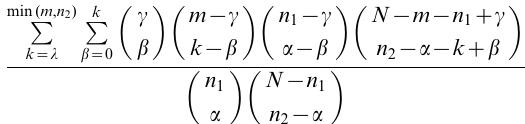
Figure S1 Two-state HMM of the Stubb program.